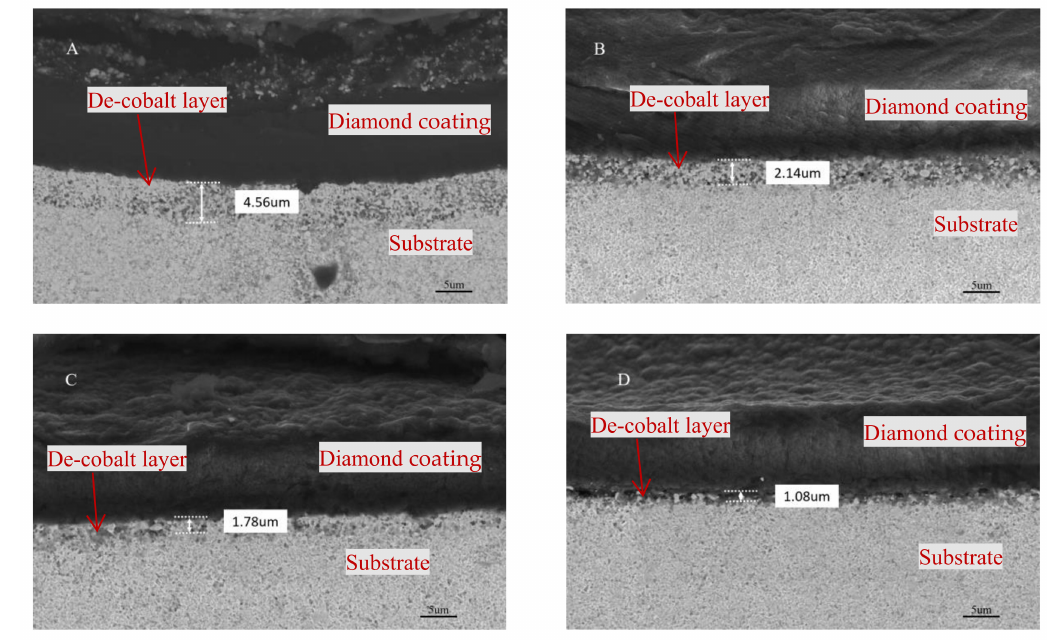
Figure 5. Cross-sectional morphology of milling tools with different pretreatment schemes. ( A ) Scheme A (Acid etching 30 s); ( B ) Scheme B (Acid etching 20 s); ( C ) Scheme C (Acid etching 15 s); ( D ) Scheme D (Acid etching 10 s).